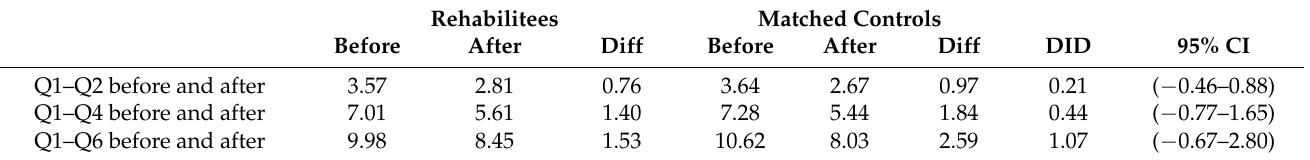
Table 2. Average number of visits in outpatient health care before the start and after the end of vocational rehabilitation among rehabilitees and their matched controls, the difference between these periods, and the difference in these differences (DID) with 95% confidence intervals. Rehabilitees Matched